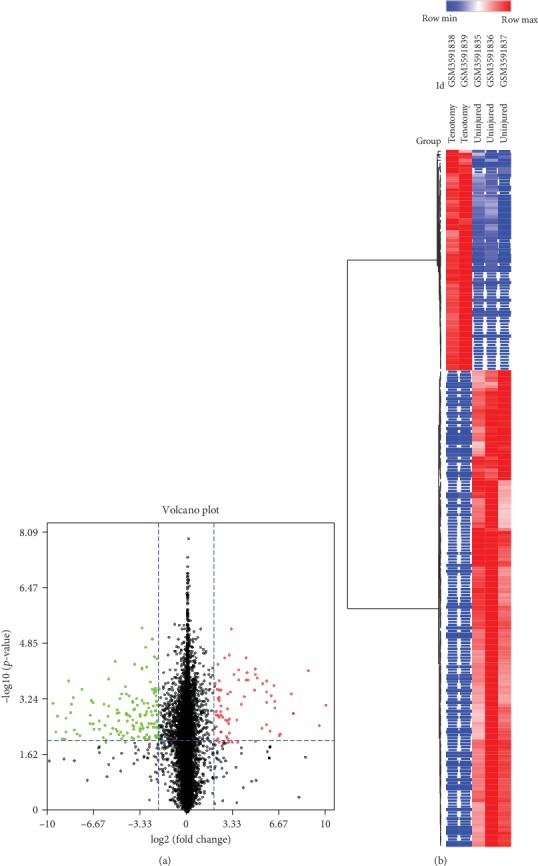
(a) Volcano plots of the DEGs between the tenotomy group and the uninjured contralateral tendon group. (b) Finally, heat map of the DEGs between the tenotomy and uninjured tendon groups. Horizontal axis represents each sample, and the vertical axis represents each gene. Blue and red colors represent low and high expression values, respectively.